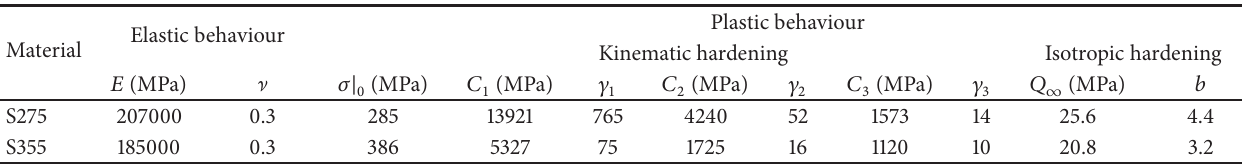
Table 4: Calibrated parameters of mild steel grade S275 and S355.